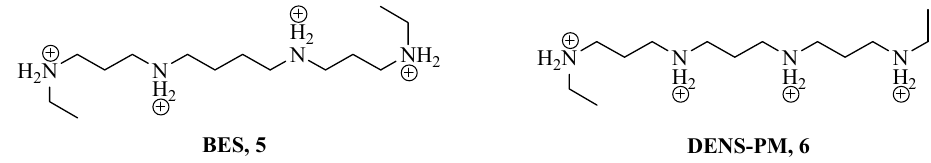
Figure 2. Chemical structures of BES ( N 1, N 12-diethyl spermine tetrahydrochloride) 5 and DENS-PM ( N 1, N 11-diethyl norspermine tetrahydrochloride) 6 . N 1, N 12-diethyl spermine tetrahydrochloride (BES) 5 and N 1, N 11-diethyl norspermine tetrahydrochloride (DENS-PM) 6 stopped cellular proliferation, induced apoptosis and showed low toxicity. From the biological viewpoint, the cell deaths induced by the use of polyamine synthetic derivatives are ascribed